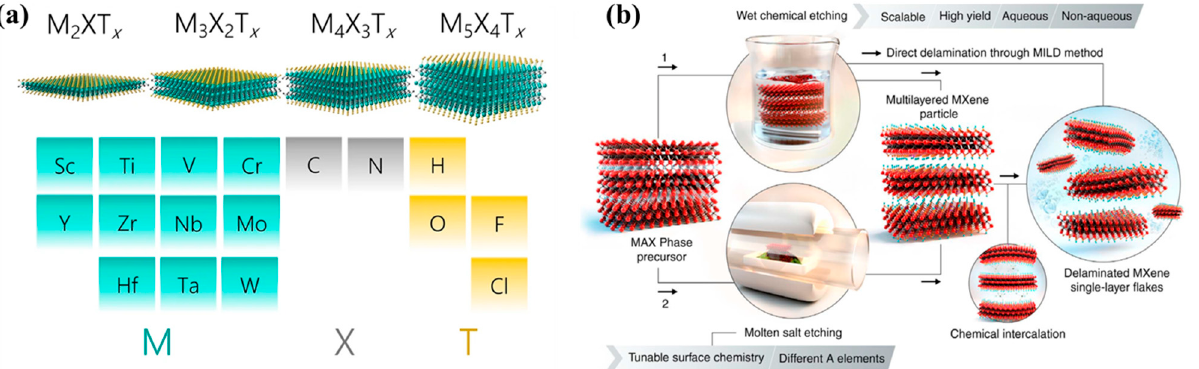
Figure 1. ( a ) Illustration of the structural categories of 2D MXenes (reproduced with permission from Ref. [51]; copyright 2021, Springer). ( b ) Schematics of the main strategies for producing MXenes by removing A layers from MAX via F-containing acids and molten salt etching (repro- duced with permission from Ref. [27]; copyright 2021, Science ).